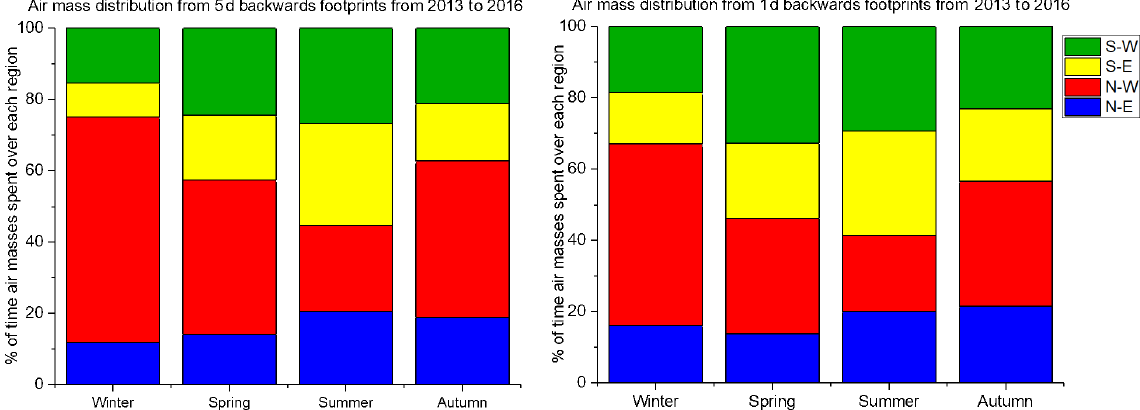
Figure 5. Frequency of the air masses arriving in Beijing from the north-west, north-east, south-west and south-east.